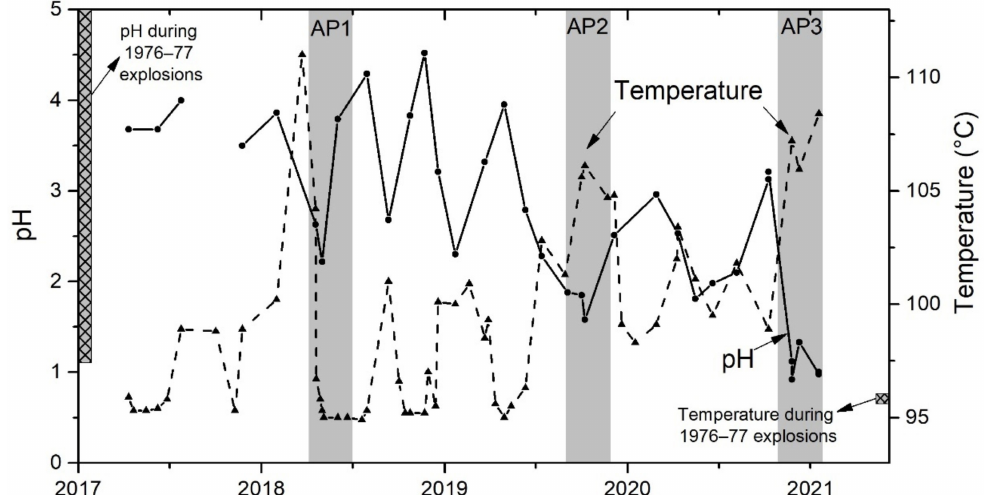
Figure 2. Outlet gas temperature (dashed black line) and pH (solid black line) of condensates from the CS fumarole for the 2017–2021 study period. Grey areas represent anomalous periods (AP) described in Section 4.2, while fill-pattern grey areas depict pH and temperature behavior during the